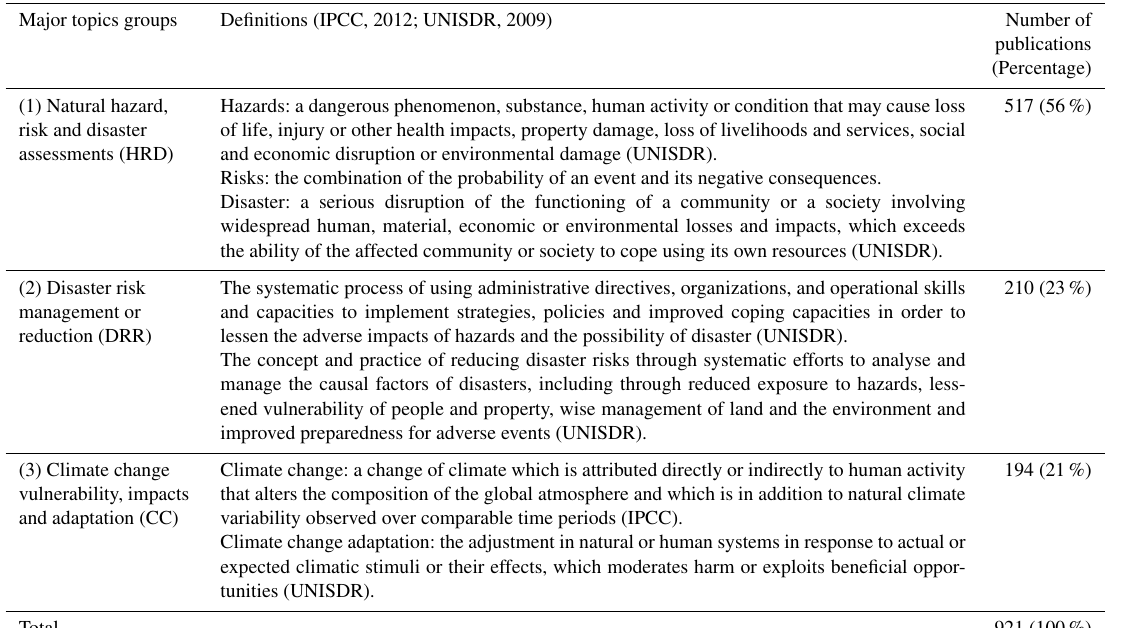
Table 2. Major research topics, descriptions and numbers of publications. Major topics